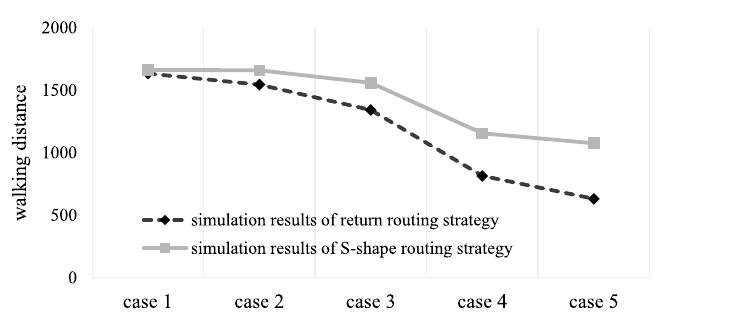
Figure 8. Comparison of simulation results of the two routing